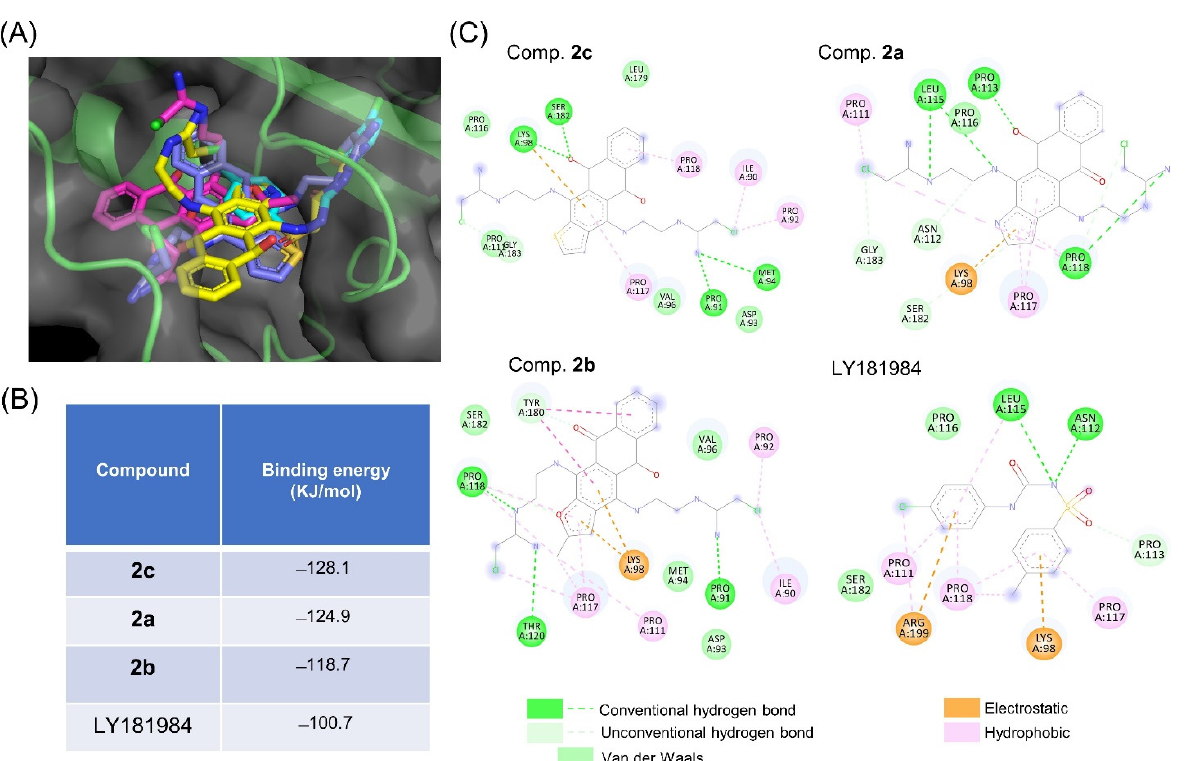
SAS (left panel) and HSC-3 (right panel) cells in the presence and absence of the studied derivatives 2c ( A ) and derivative 2a ( B ) in the CETSA experiments as described in the Materials and Methods. Aliquots of cell lysates were resolved by SDS-PAGE and analyzed for protein expression by Western blotting. β -actin was used as an internal loading control to monitor for equal loading. Representative images are shown. Bottom panel: CETSA melting curves of tNOX in the presence and absence of derivatives 2c ( A ) and derivative 2a ( B ) in SAS (left panel) and HSC-3 (right panel) cells. The immunoblot intensity was normalized to the intensity of the 40 ◦ C samples. ( C ) Left panel: the immunoblot intensity of tNOX in HSC-3 cells in the presence and absence of the studied derivatives 2b in the CETSA experiments. Right panel: CETSA melting curves of tNOX in the presence and absence of derivatives 2b in HSC-3 cells. The uncropped blots and molecular weight markers are shown in Supplementary Figure S4.